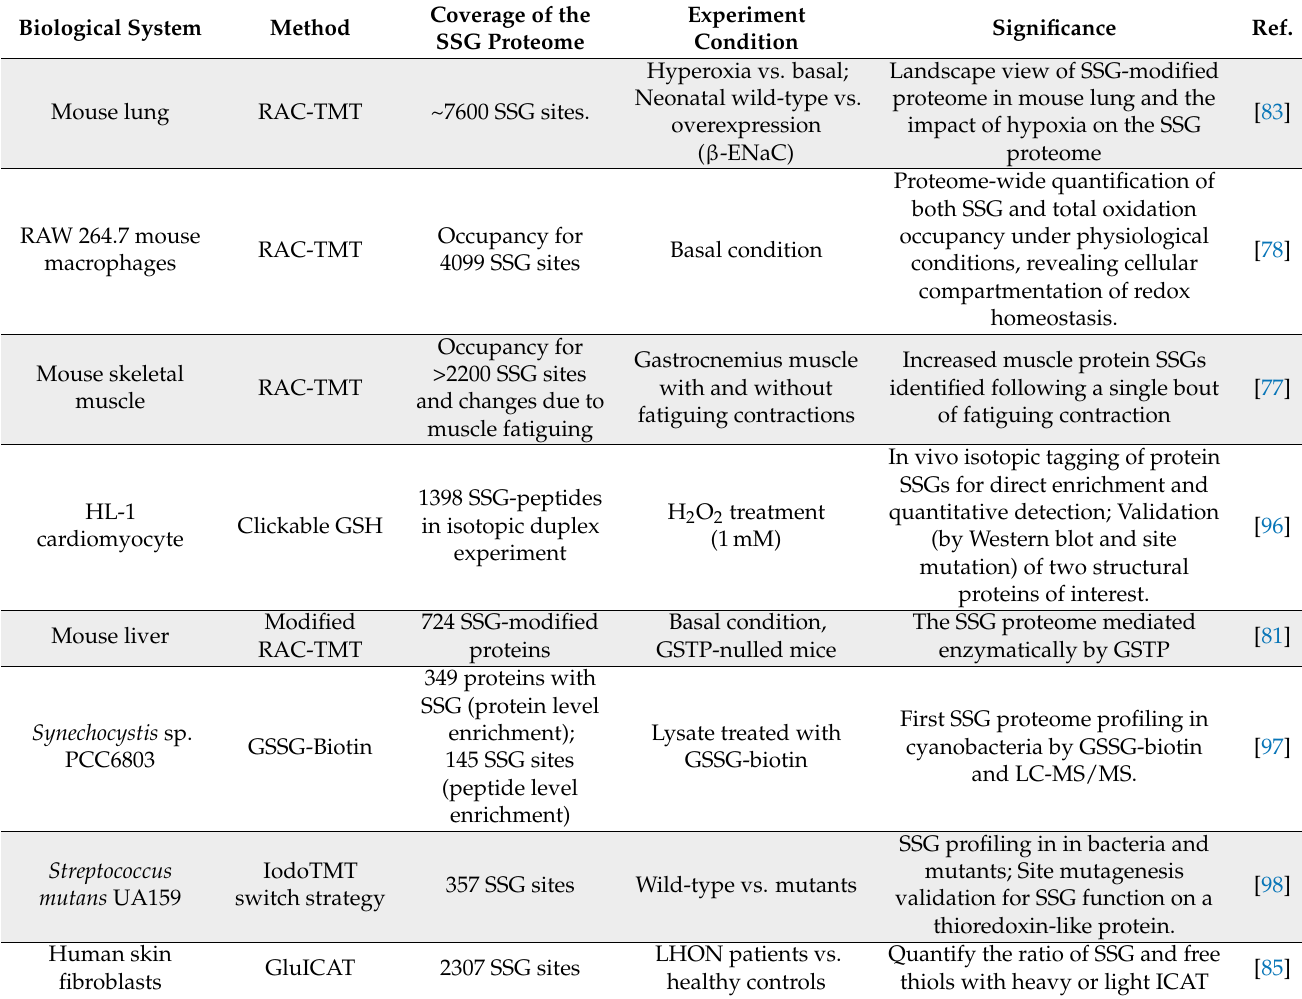
Table 1. Selected MS-based profiling studies of the SSG